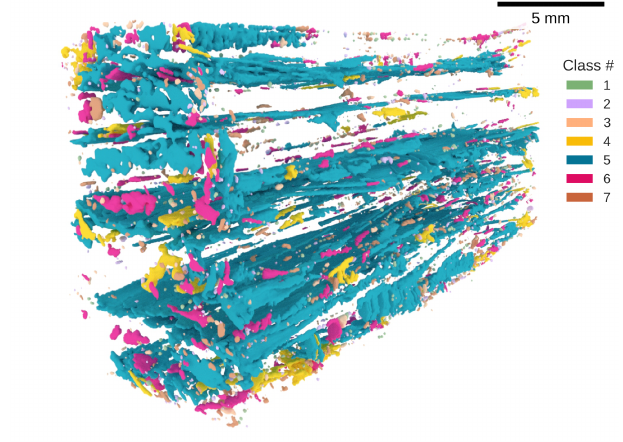
Figure 8. Three-dimensional visualization of defects in specimen a6 with the seven morphological classes